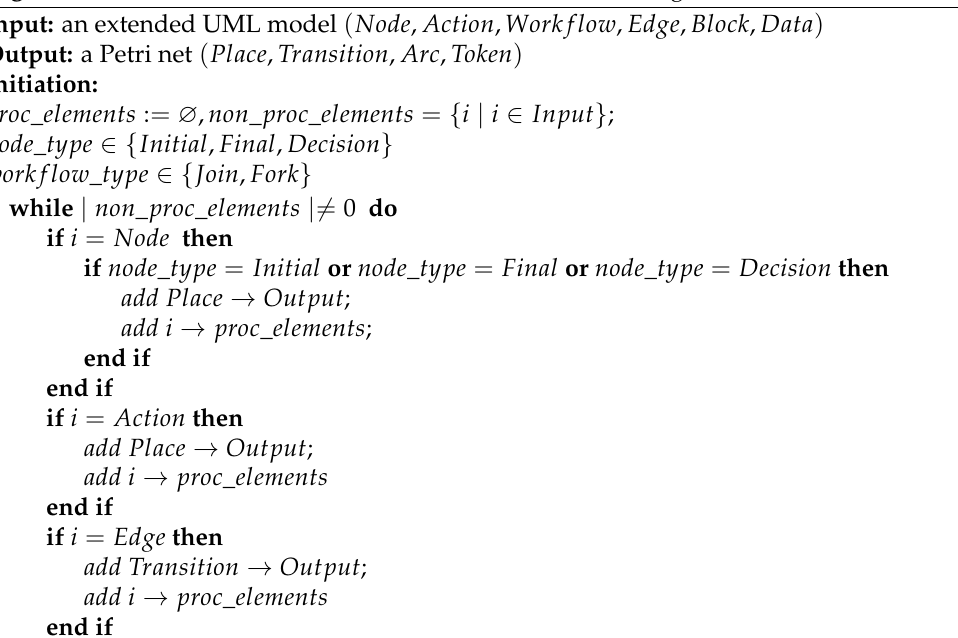
Algorithm 1 Extended UML AD to Petri net Transformation